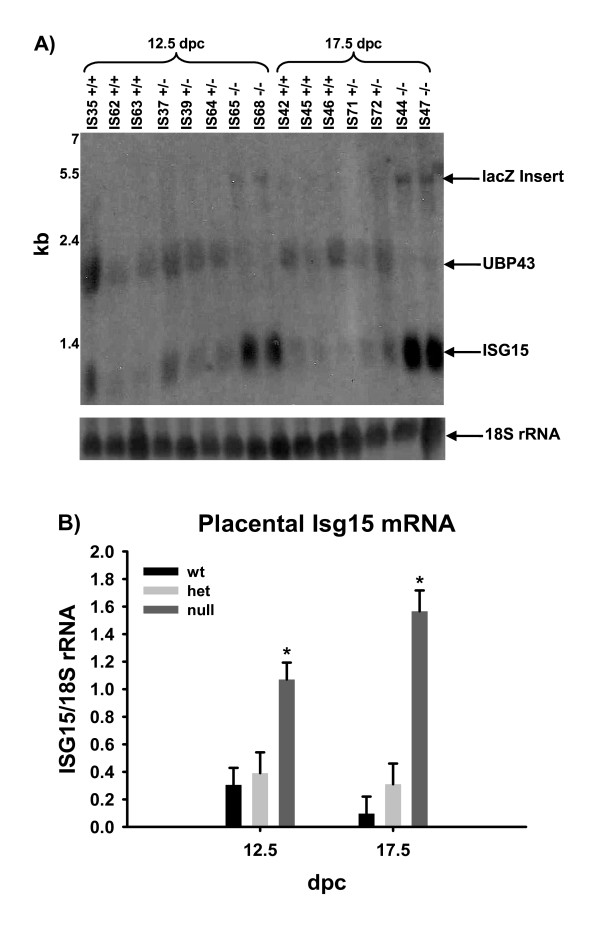
Northern blot analysis for Ubp43 and Isg15 (panel A). Fetal chorioallantoic placental RNA was analyzed for Ubp43 and Isg15 using cDNA probes. Isg15 mRNA was present on 12.5 and 17.5 dpc in all genotypes. Ubp43 mRNA was present in wt and het tissues at the correct size. 18S rRNA was not different. Panel B represents a graphical interpretation of the expression of Isg15 in fetal chorioallantoic placenta. Isg15 mRNA was greater in null derived placenta in comparison to wt or het placenta. Means are LSM ± SE and represent 3 +/+, 3 +/-, and 2 -/- on 12.5 dpc, and 3 +/+, 2 +/- and 2 -/- fetal chorioallantoic placenta. * denotes P < 0.07.